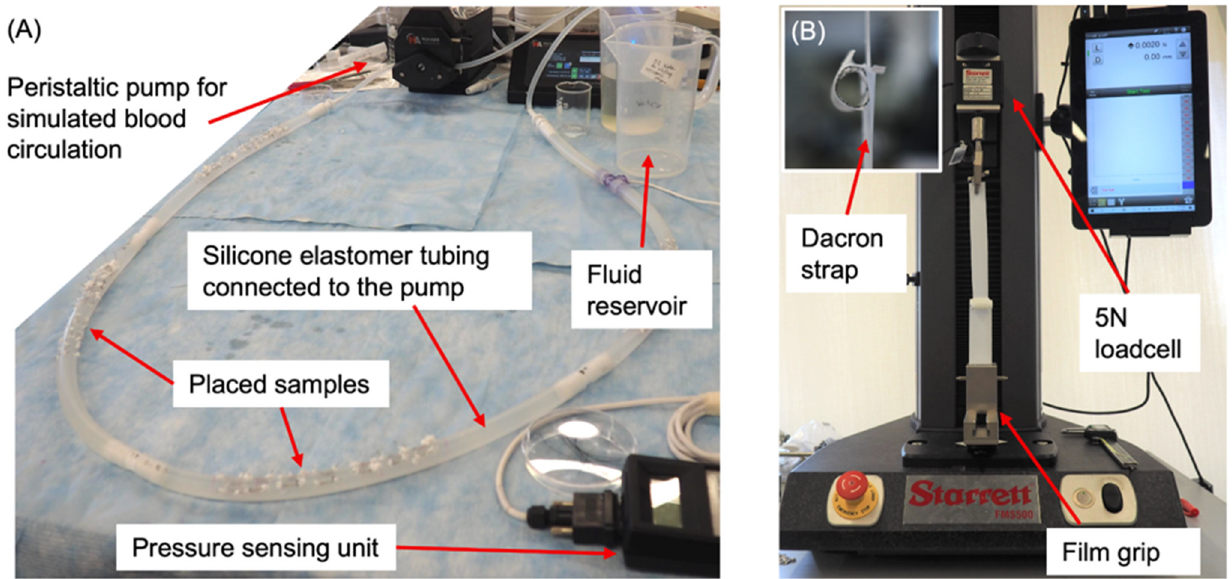
Figure 3. In vitro test device performance test setups: ( A ) degradation test setup, and ( B ) radial force measurement test setup.